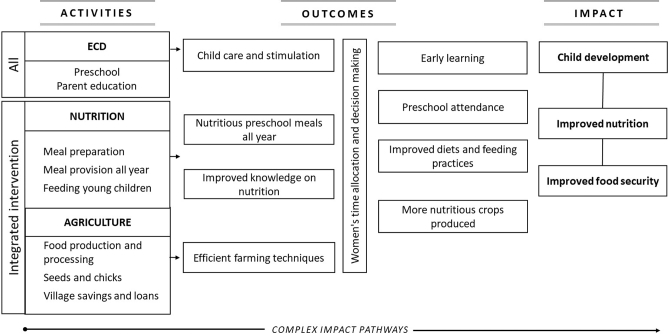
Schematic view of the program impact pathways for the integrated agriculture and nutrition intervention in the NEEP-IE study. NEEP-IE, Nutrition Embedded Evaluation Program Impact Evaluation.